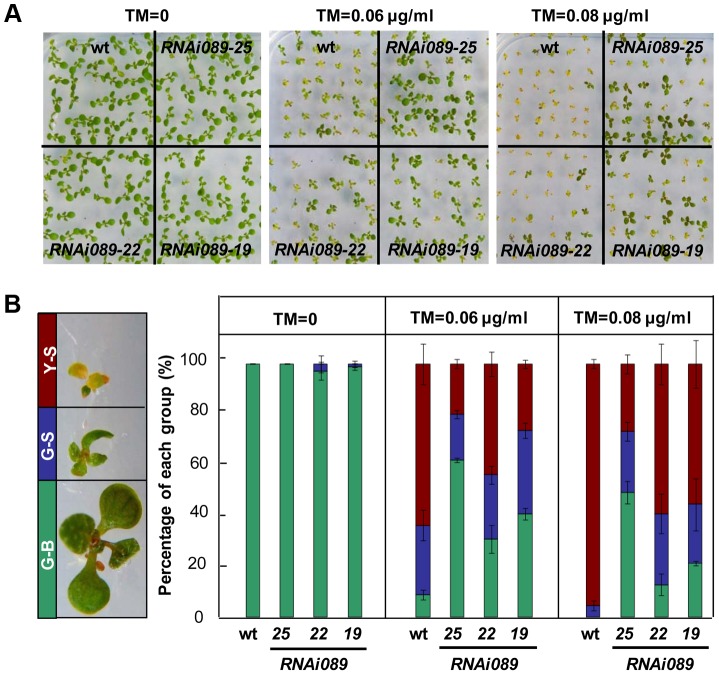
Down-regulation of NAC089 confers ER stress tolerance.(A–B) Sensitivity of NAC089 RNAi plants to ER stress. Photos were taken with 10-day-old Arabidopsis seedlings grown on 1/2 MS medium supplied without or with different concentrations of tunicamycin (TM) (A) and percentage of green-big (G-B), green-small (G-S) and yellow-small (Y-S) plants was calculated (B). Bars depict SE (n = 3). The difference between the wild-type (wt) and each NAC089 RNAi line is significant (P<0.05).